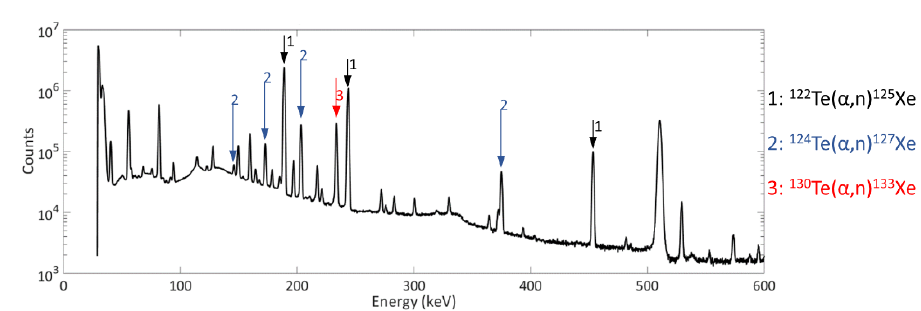
Fig. 2. The γ-spectrum after the 17MeV irradiation. The relevant γ-peaks are labelled. In the case of 130 Te(α,n) 133 Xe only the isomeric state γ-peak is